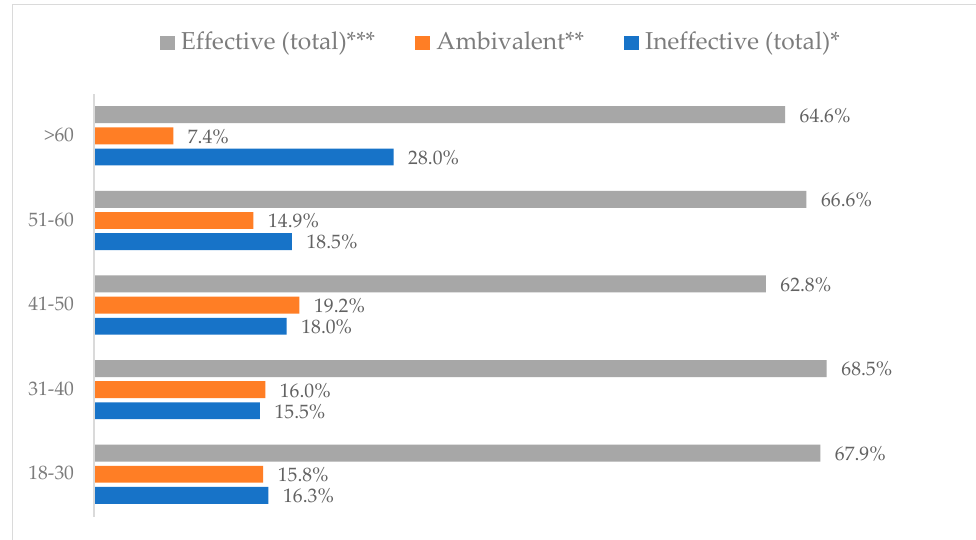
Figure 1. Wearing a protective mask that covers the mouth and nose to prevent influenza virus infection by gender ( N = 905). *Sum of responses: completely ineffective, ineffective, rather ineffec- tive; **Response: neither ineffective nor effective; ***Sum of responses: rather effective, effective, completely effective.